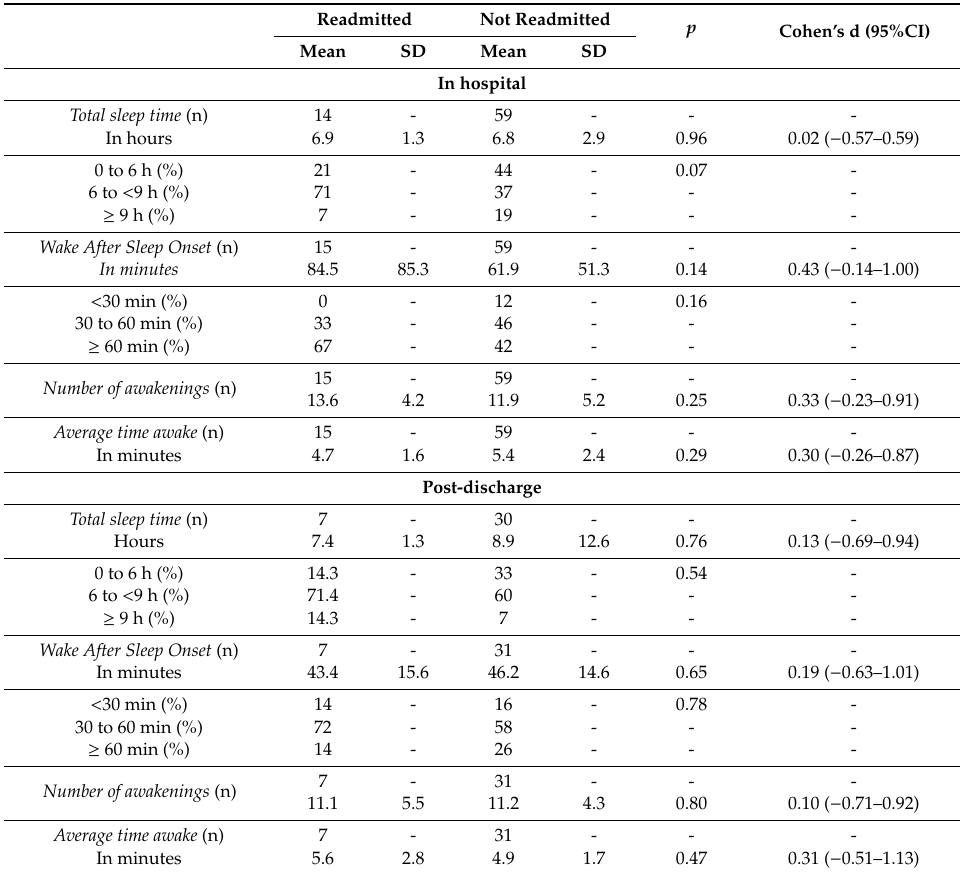
Table 2. In-hospital and post-discharge ActiGraph